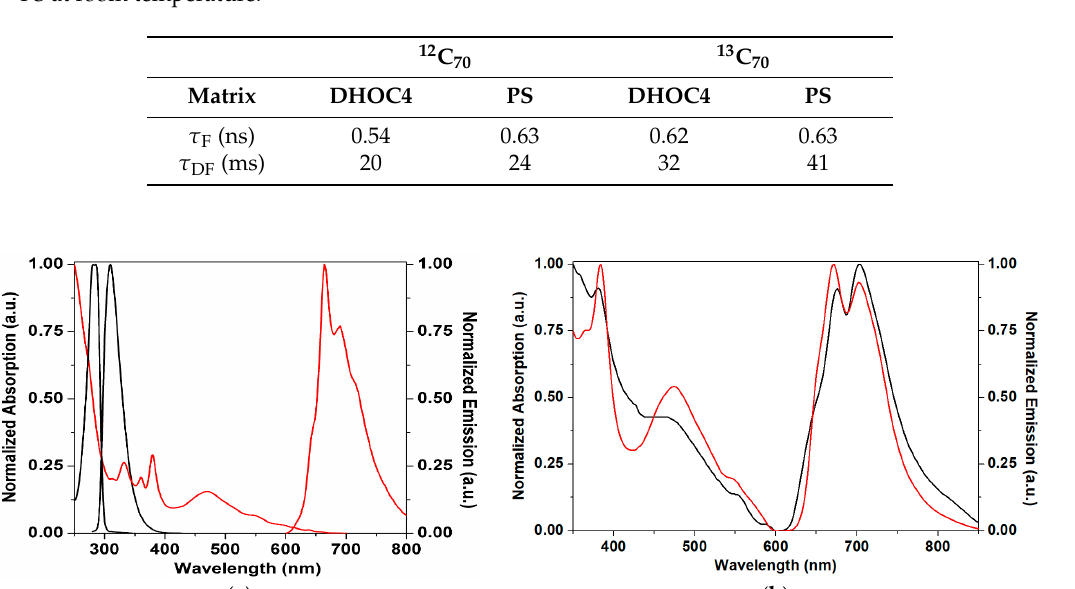
Table 1. Fluorescence ( τ F ) and delayed fluorescence ( τ DF ) lifetimes of 12 C 70 and 13 C 70 in DHOC4 and PS at room temperature.